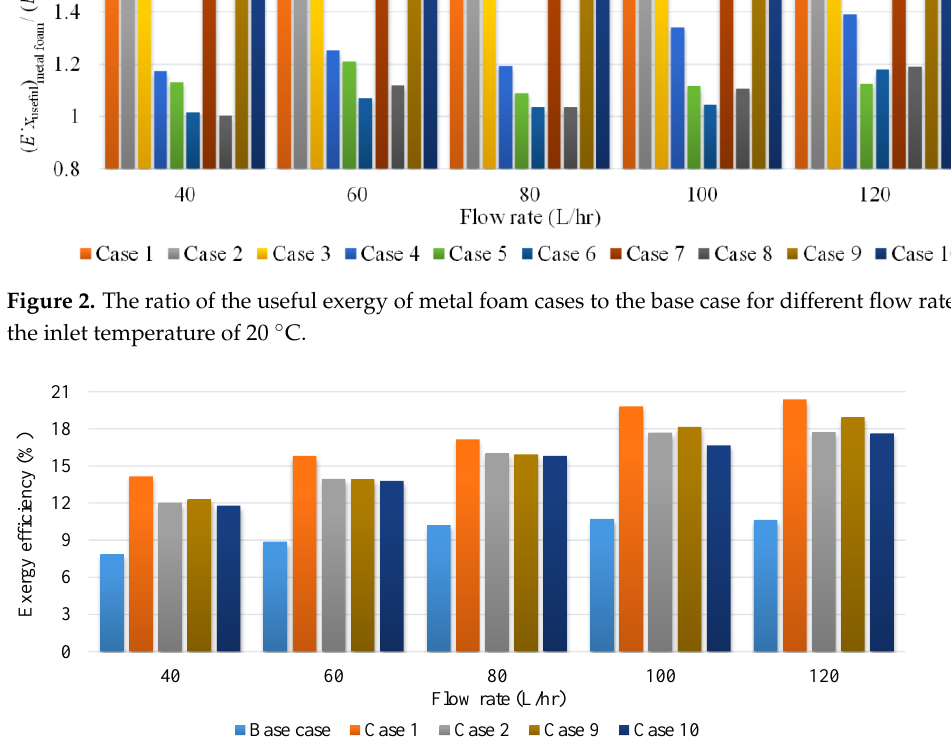
Figure 4. Entropy generation ratio of ( a ) fully porous and ( b ) semi-porous cases at different flow rates for the inlet temperature of 20 °C.